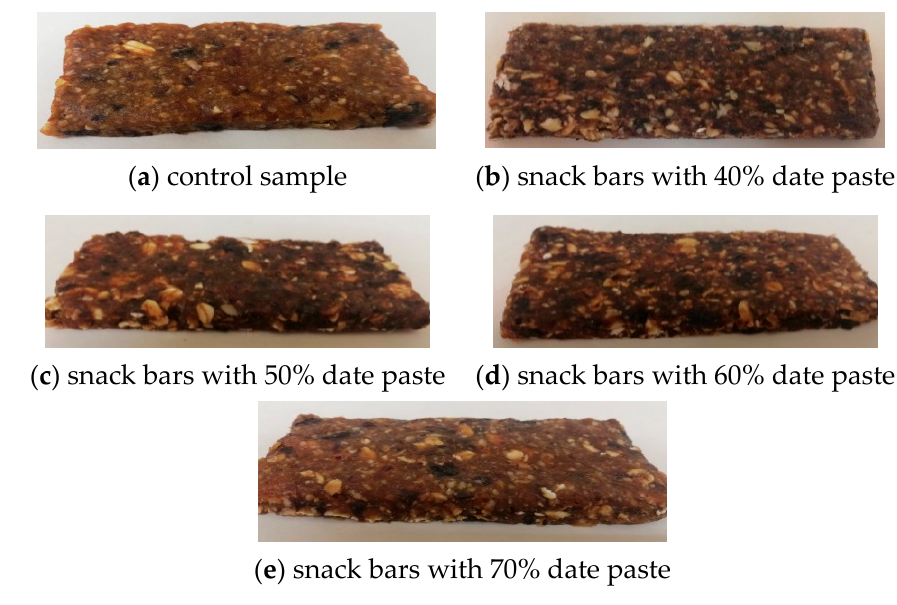
Figure 2. Snack bars with ( a ) control sample; ( b ) 40% date paste; ( c ) 50% date paste; ( d ) 60% date paste; ( e ) 70% date paste.